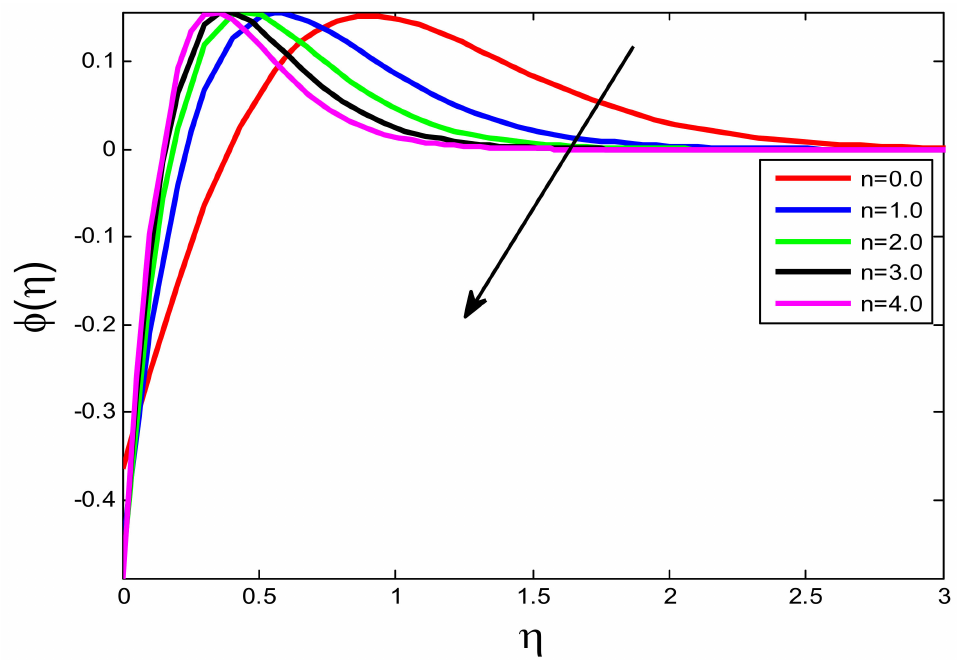
Figure 7. Influence of n on φ ( η )